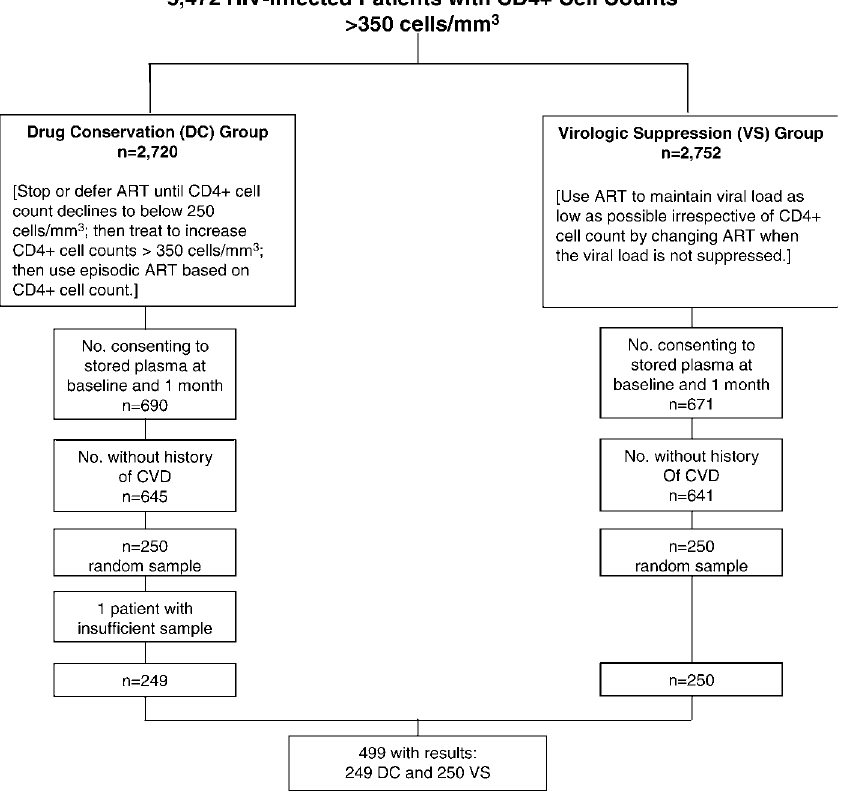
Figure 2. SMART Study Design and Flow Diagram for Random